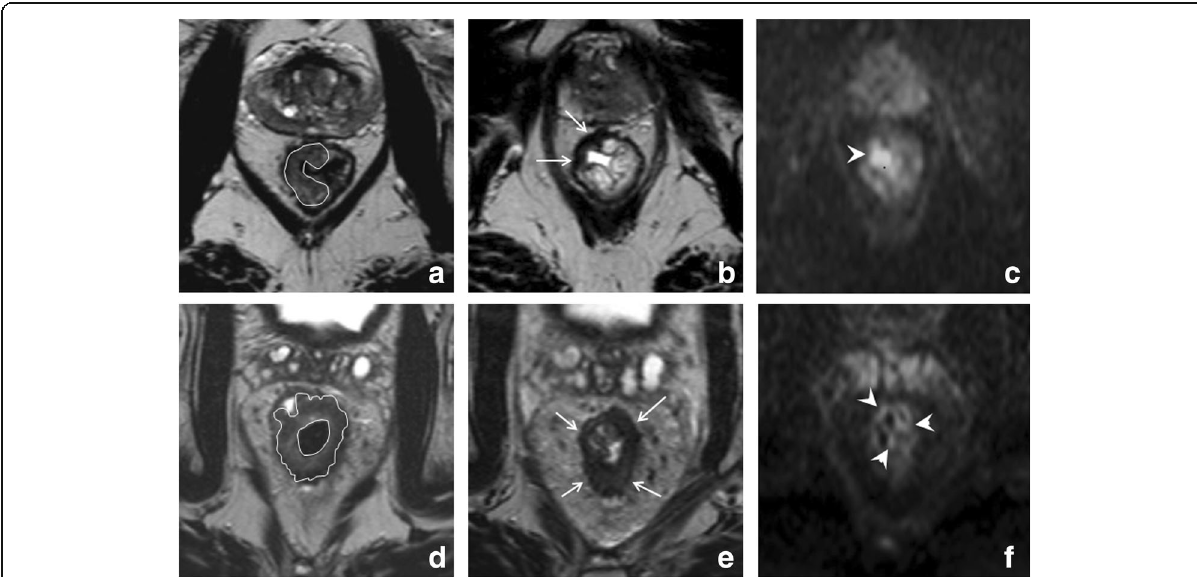
Fig. 10 Patterns of response on DWI. Pre-CRT T2-weighted ( a , d ), post-CRT T2-weighted ( b , e ), and corresponding post-CRT b1000 DWI ( c , f ) images of two male patients treated for low rectal tumors. In the upper patient, a semicircular solid mass is visualized before treatment ( a ). After CRT, a focal fibrotic wall thickening is observed (arrows in b ), without a clear residual mass. On DWI, a focal high signal is observed at the inner margin of the fibrosis (arrowhead in c ), which was later histopathologically confirmed to be a ypT2 tumor remnant. The patient in the bottom row has a large, irregular circular tumor mass pre-CRT ( d ). After CRT, an irregular and slightly heterogeneous fibrotic wall thickening was observed (arrows in e ) with small spots of high DWI signal (arrowheads in f ) scattered throughout the fibrosis. This patient was confirmed to have a ypT3 tumor remnant at